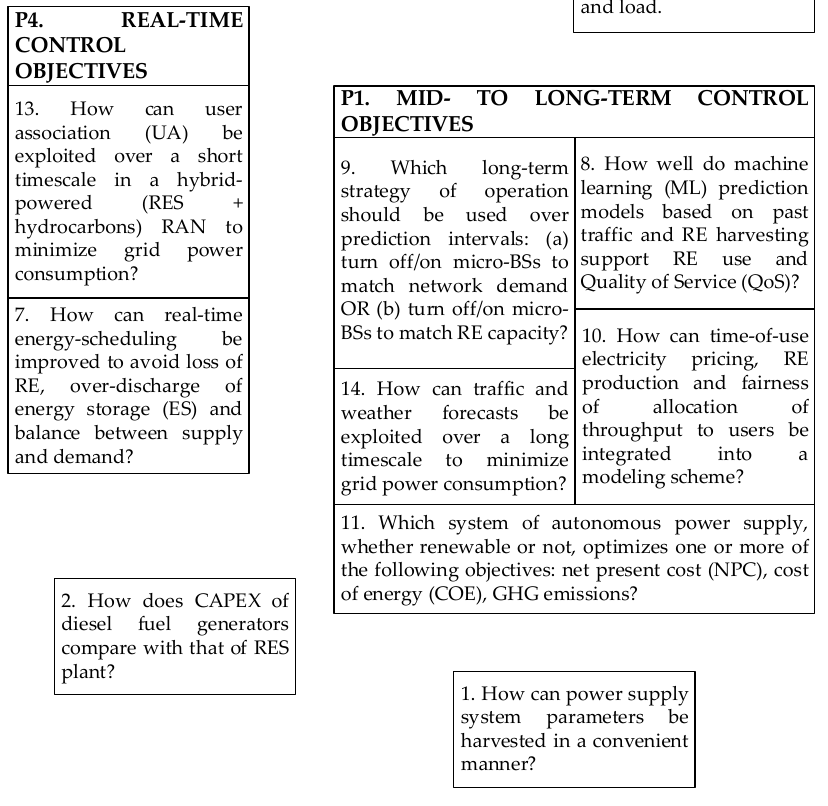
Figure A1. A first categorization of the problem nodes. P1: 8 [145], 9 [145], 10 [146], 11 [147], 14